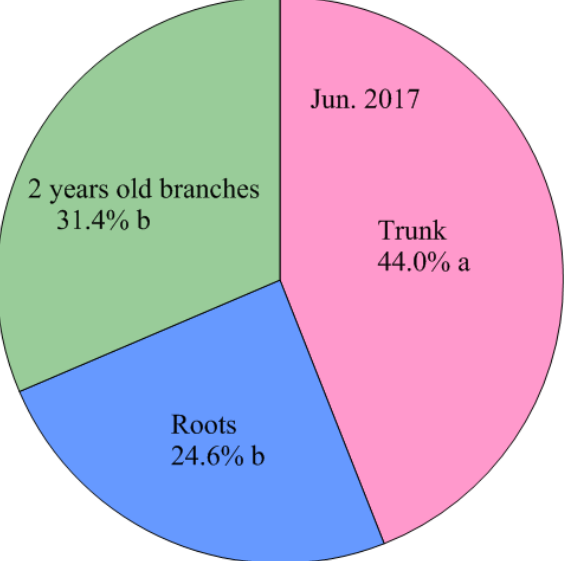
Figure 4. The ratio of N 2016 supplied by each perennial structure of pear trees to total remobilized N 2016 in spring of 2017. N 2016 means amount of fertilizer-N derived in 2016. Different small letters indicate significant differences ( p < 0.05) among organs.